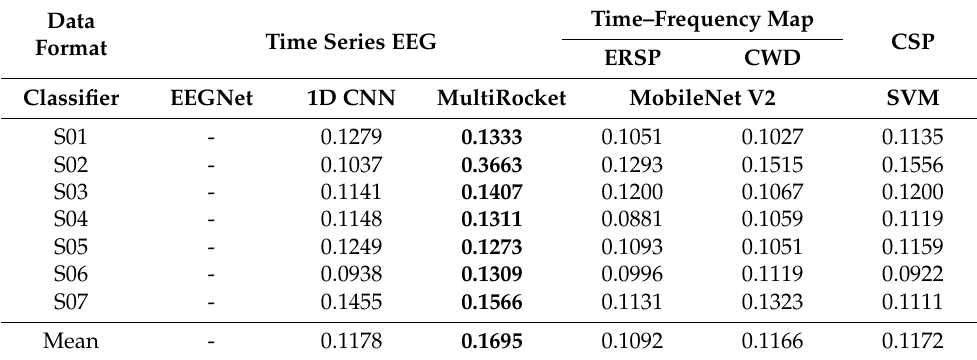
Table 4. Each subject’s classification accuracy of 9-category VI according to the data type and